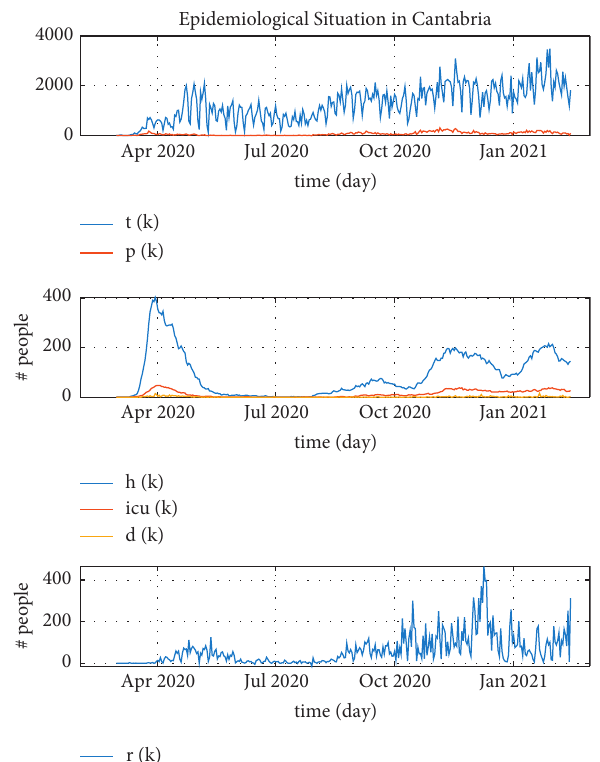
Figure 4: Epidemiological situation in